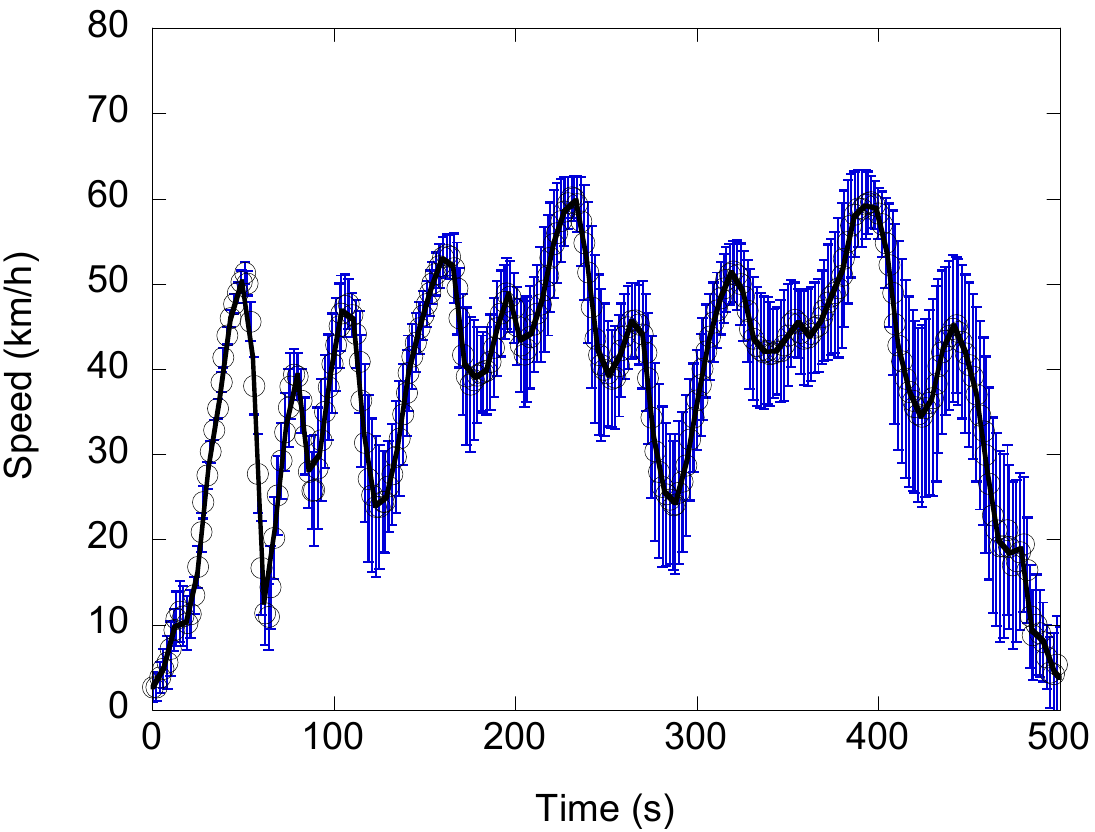
Figure 3. Average speed plot of the on-road route.